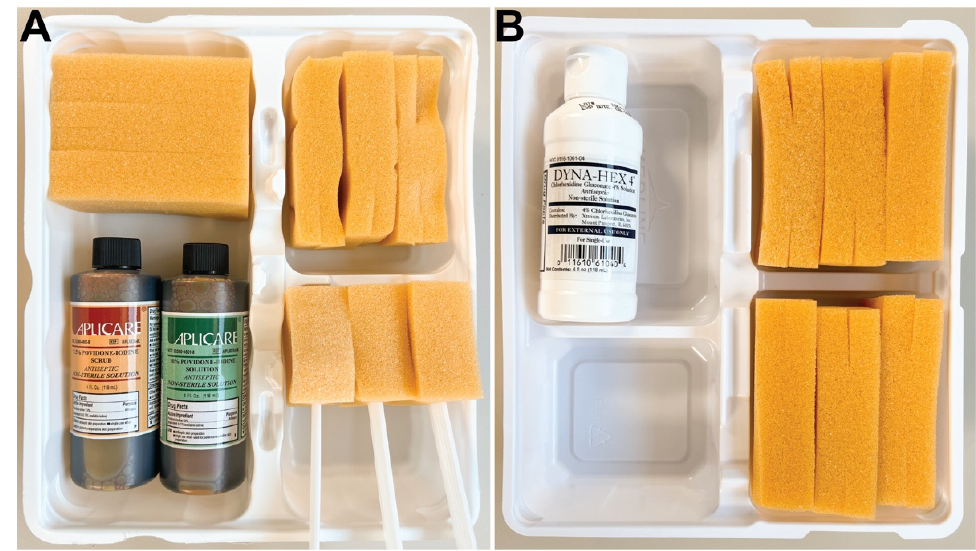
Figure 1. PVP-I and CHG presurgical scrub trays used for this work. Swabs included in each kit were not used during the preparation: ( A ) Alcohol-based Wet Premium Skin Scrub Tray with PVP-I (PSP kit, 7.5% scrub and 10% paint solution) from BD was used for pigs 1–5; ( B ) Alco- hol-based Wet Skin Scrub Tray with CHG (PSP kit, 4% CHG solution) from Medline was used for pigs 6–10.